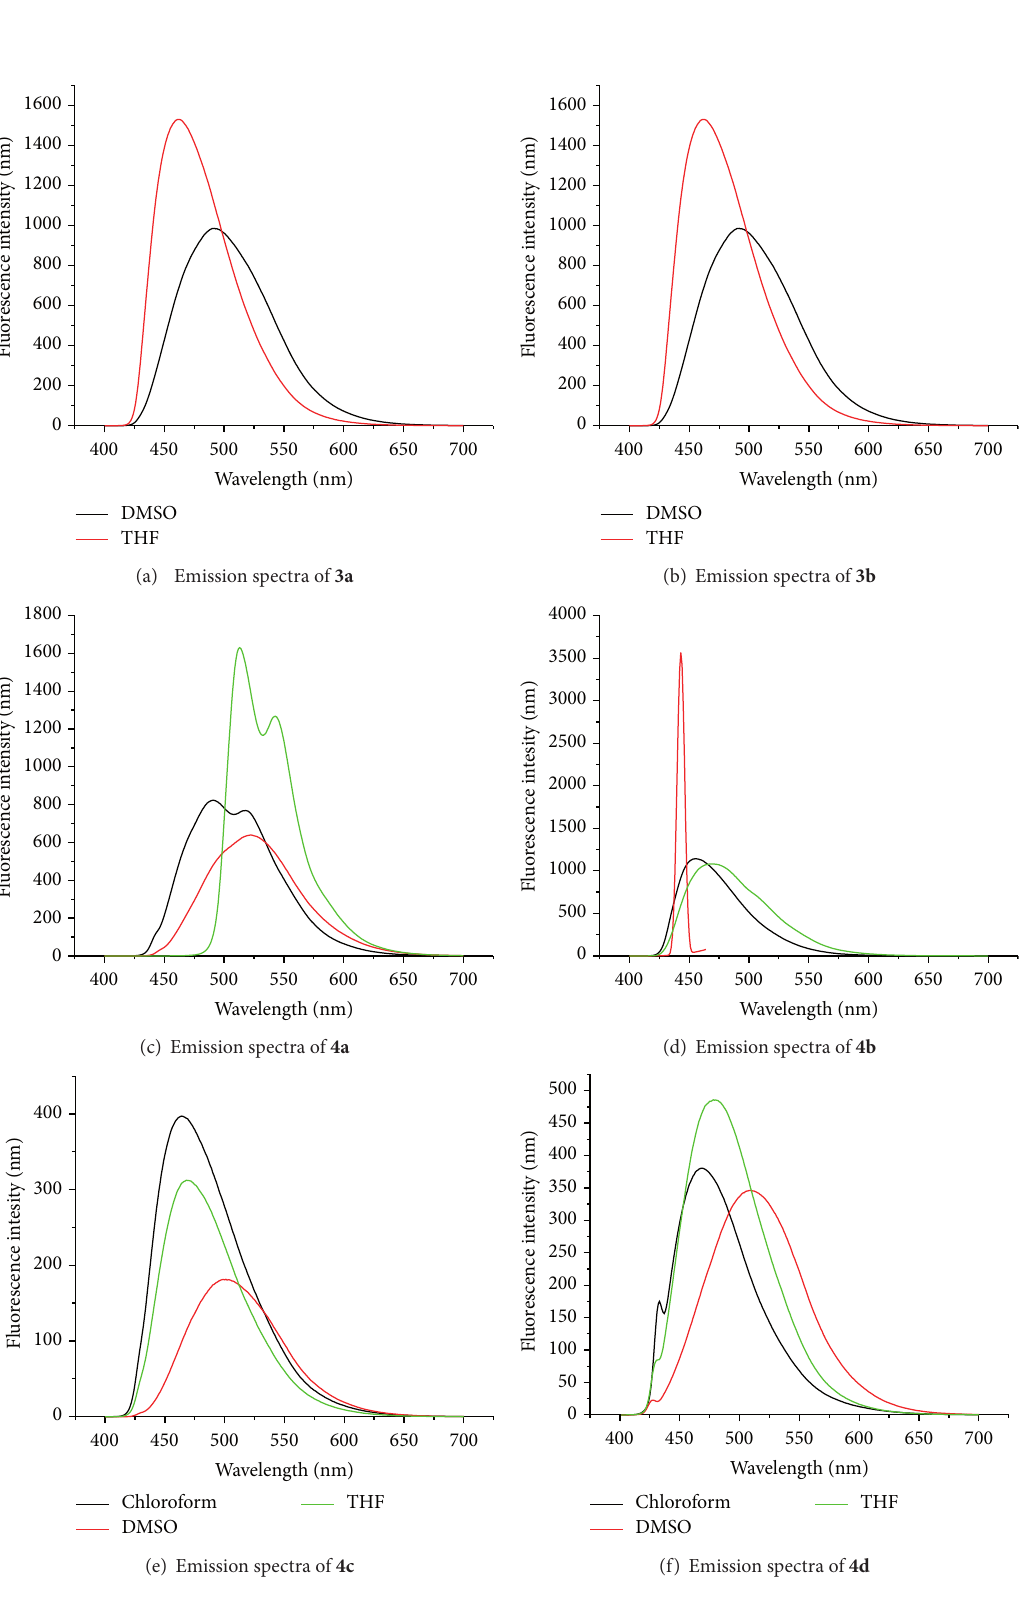
F 2: Emission spectra of compounds 3(a-b) and 4(a – d ) in different